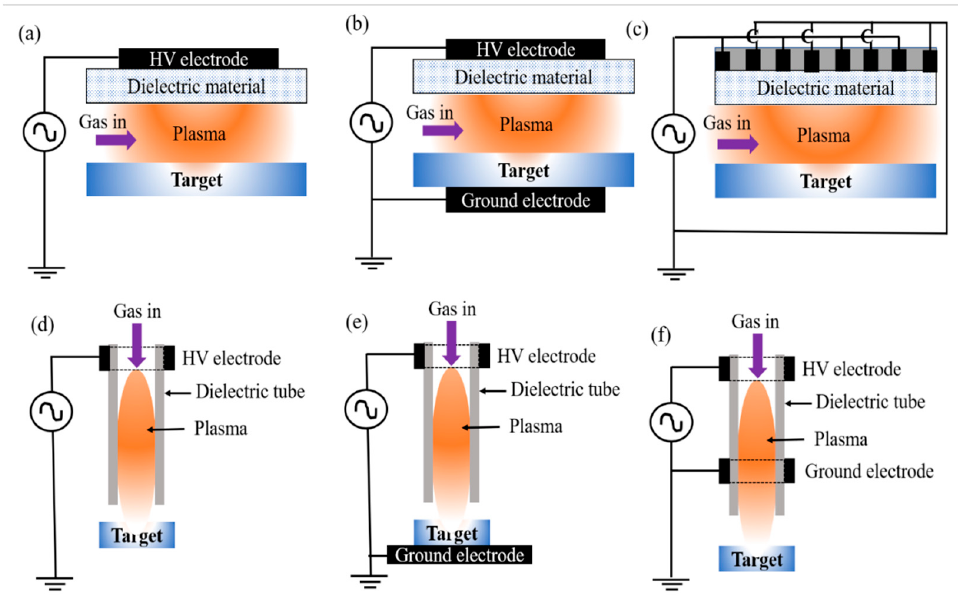
Figure 2. Schematic diagrams of DBD plasma sources: ( a ) floating electrode DBD plasma source, ( b ) facing electrode DBD plasma source, ( c ) surface DBD plasma source, ( d ) floating electrode plasma jet, ( e ) direct plasma jet, and ( f ) indirect plasma jet treating a sample.